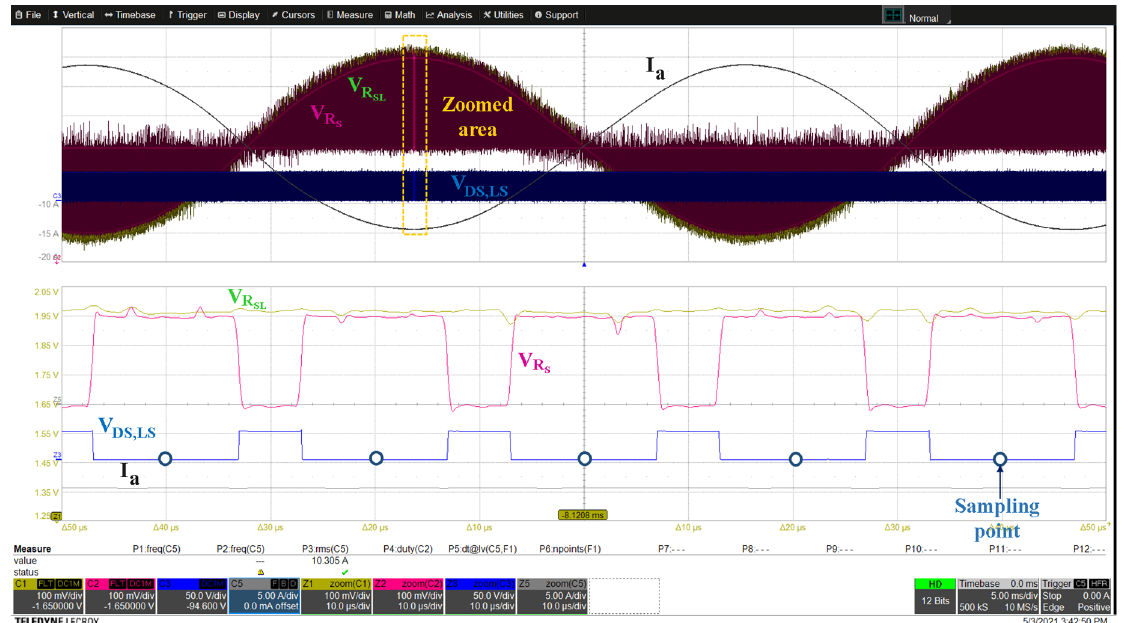
Figure 9. Sensing circuit in the two cases of phase and bridge leg voltage detection solution. Experimental waveforms during switching cycles and a zoomed view. The sampling point positions for the analog to digital signal are highlighted. I a = 5 A/div, V DS,LS = 50 V/div, V RS = V RSL = 100 mV/div, switching cycle t = 5 ms/div, zoomed view t = 10 µ